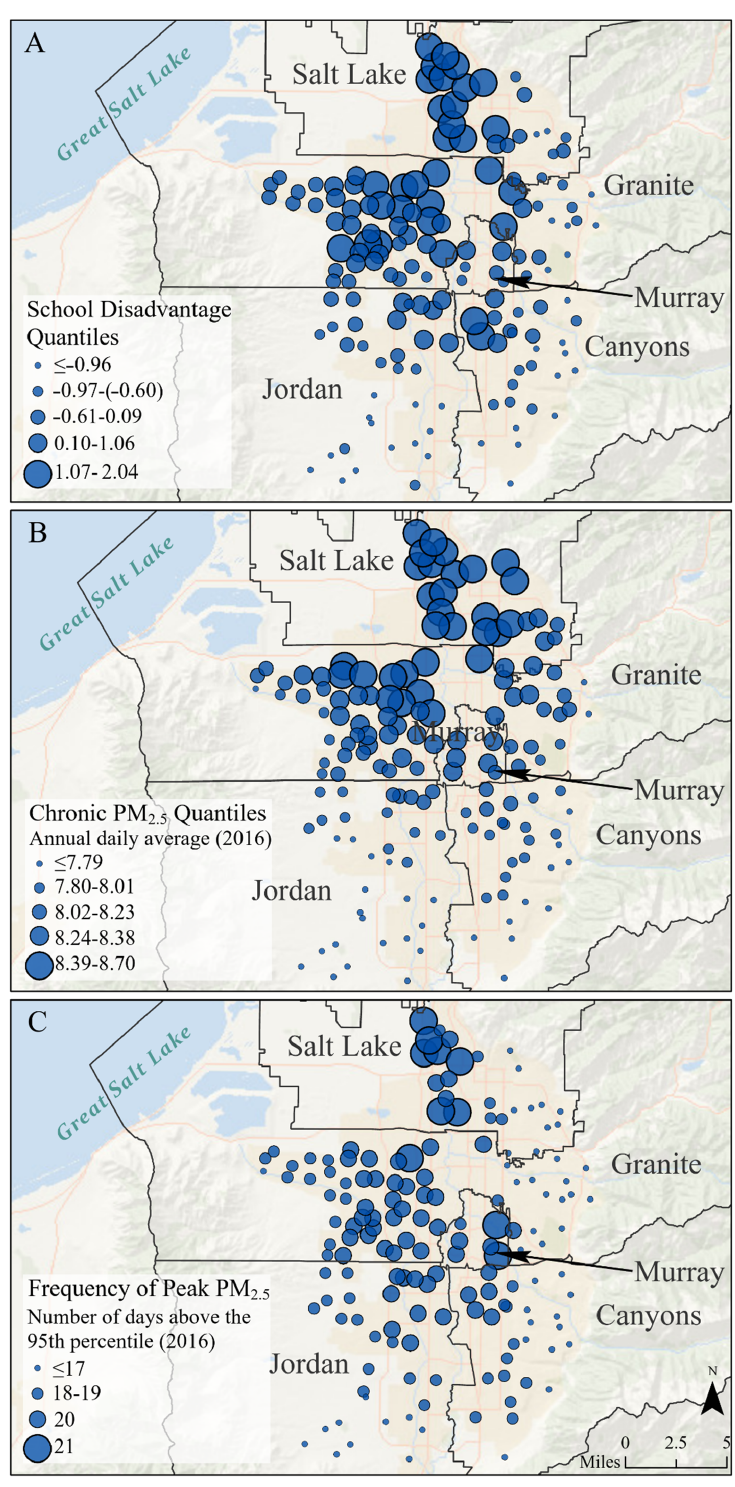
Figure 2. Three maps depicting school disadvantage ( A ), chronic PM 2.5 pollution ( B ), and the frequency of peak PM 2.5 pollution ( C ) at Salt Lake County schools ( n = 156). Note: School disadvantage is presented in units of standard deviation. Chronic PM 2.5 is presented in units of µ g / m 3 . Peak PM 2.5 represents the number of days that the school tract’s PM 2.5 level was over the 95th percentile of the daily mean of all tract days in Salt Lake County (i.e., 22.80 µ g / m 3 ) and is presented in units of